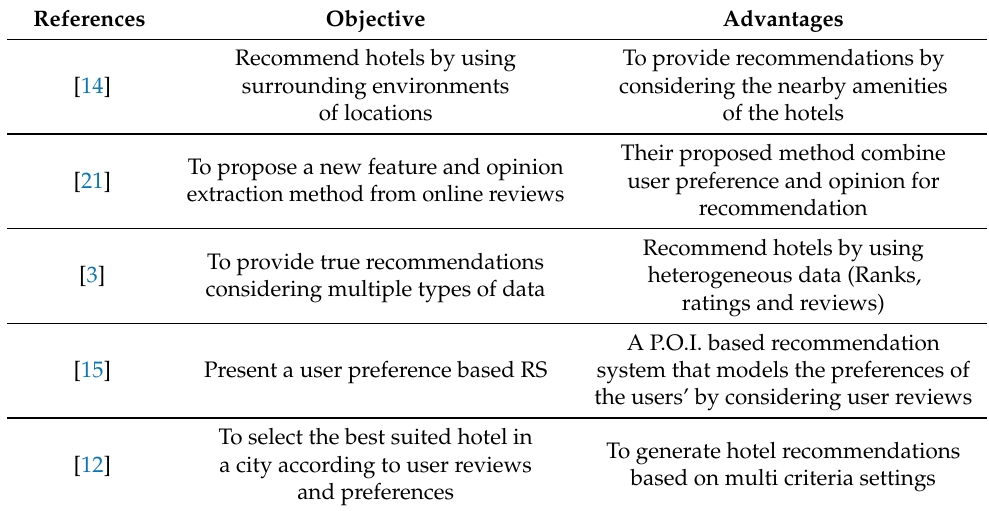
Table 3. The objective and advantages of the various RS (Recommendation